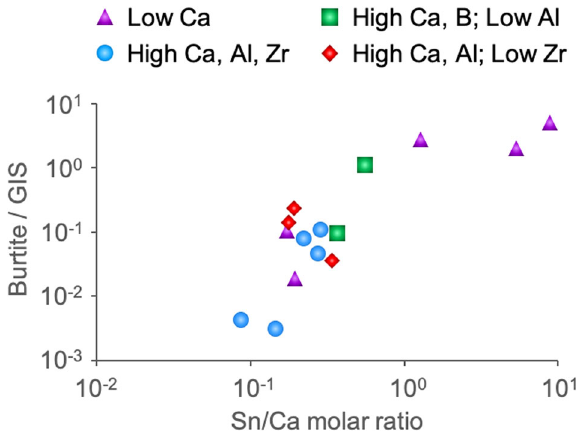
Fig. 5 Effect of Sn/Ca ratio. Logarithmic relationship between the relative amounts of burtite and GIS by weight in the fi nal product (calculated from PXRD patterns using MgO as an internal standard) as a function of the initial Sn/Ca molar ratio of the growth mixture. Color coding of data points is based on the classi fi cation of each glass according to Fig. 2a, which corresponds to alteration responses for glasses with low CaO (purple triangles); high CaO, Al 2 O 3 , ZrO 2 (blue circles); high CaO, B 2 O 3 , and low Al 2 O 3 (green squares); and high CaO, Al 2 O 3 , and low ZrO 2 (red diamonds). Some samples are not plotted, which do not contain a quanti fi able amount of burtite according to their PXRD pattern. Elemental forms rather than oxide forms are used in the fi gure for brevity.